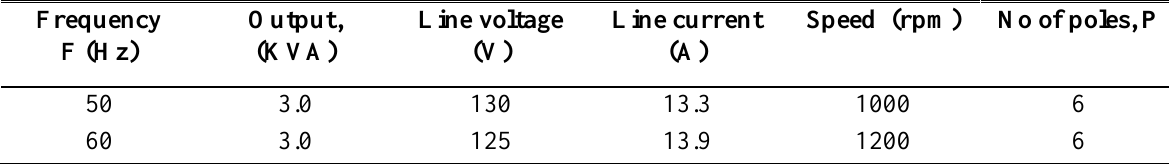
Table 1: The voltage and current ratings at two